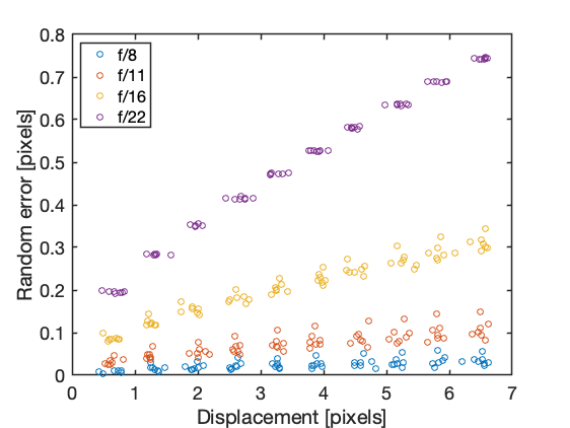
Figure 5. Random error in displacement as a function of speckle motion using different aperture numbers and analyzed using the seven different correlation functions. All results for the same aperture setting are lumped